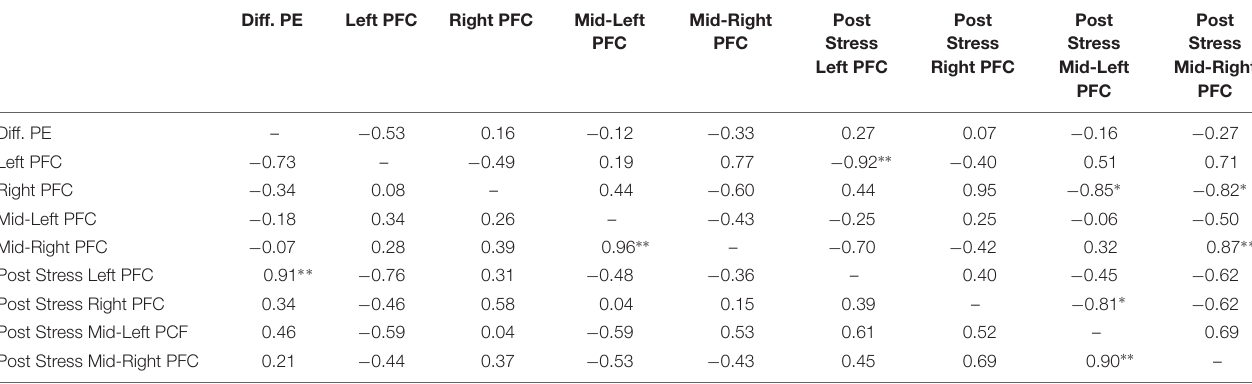
TABLE 4 | Bivariate correlations between oxyHB and change in perseverative errors for male participants as a function of condition (Stress vs. Control), values above the diagonal are for the control group and values below the diagonal are for the stress group.